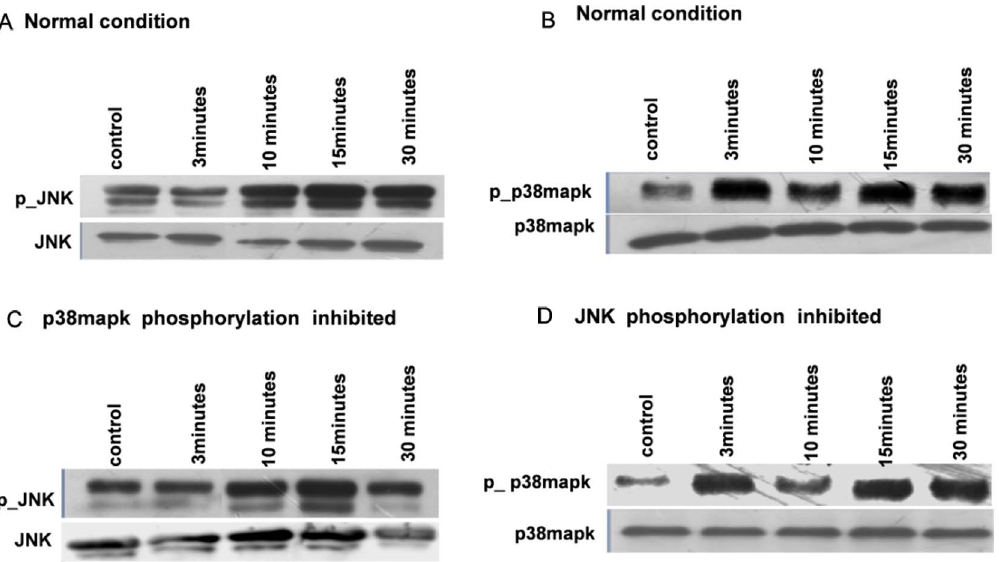
Figure 5. Experimental validation of the amplification of activity in one branch on inhibiting the activity of the terminal kinase in the other branch. Western blots of JNK and p38MAPK phosphorylation in primary macrophages when subjected to CD40 stimuli of strength 3 m g/ ml are shown under normal (JNK: A, p38MAPK: B) and perturbed (JNK: C, p38MAPK: D) conditions. Perturbation is applied by inhibiting the phosphorylation of either p38MAPK (C) or JNK (D) by using pharmaceutical agents. In each figure, the upper and lower panels show the phosphorylated and total concentrations of the different molecular species (represented by ‘‘p JNK’’ and ‘‘JNK’’, and ‘‘p- p38’’ and ‘‘p38’’ for JNK and p38MAPK respectively). The control condition shows an unstimulated system, while the times 3, 10, 15 and 30 minutes refer to observations after